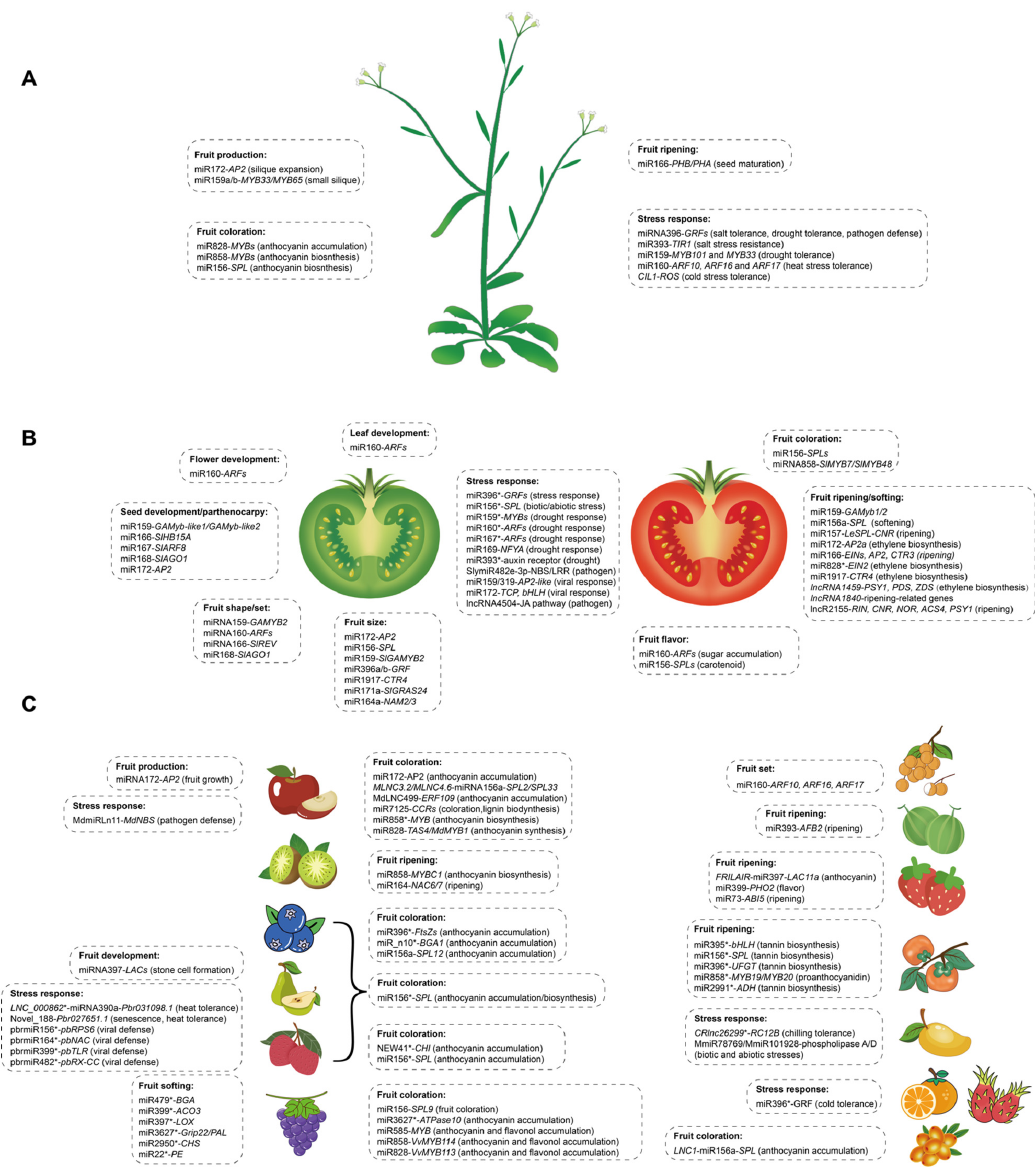
Figure 1. Diverse function of miRNA and lncRNA members in fruit crops: ( A ) Arabidopsis , ( B ) tomato and ( C ) fruit crops (fruit species on left: apple, kiwifruit, blueberry, pear, litchi, grape; fruit species on right: longan, melon, strawberry, persimmon, mango, orange, pitaya, and sea buckthorn). The asterisk (*) represents bioinformatics analysis data.